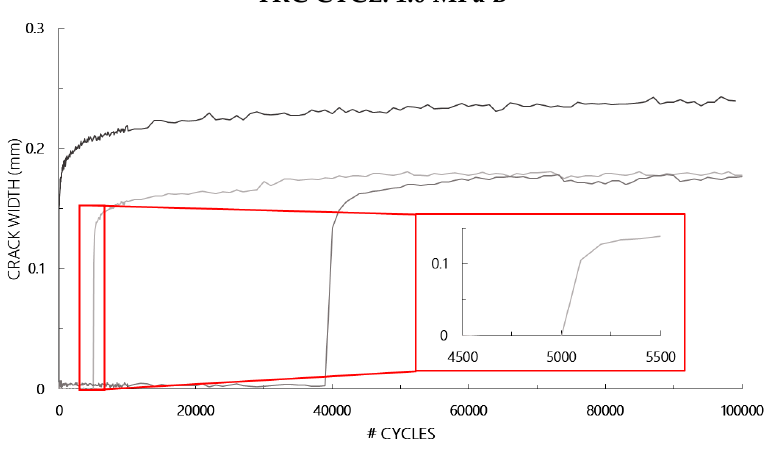
Figure 9. Evolution of the crack width of some representative cracks formed during cyclic loading of TRC coupons.